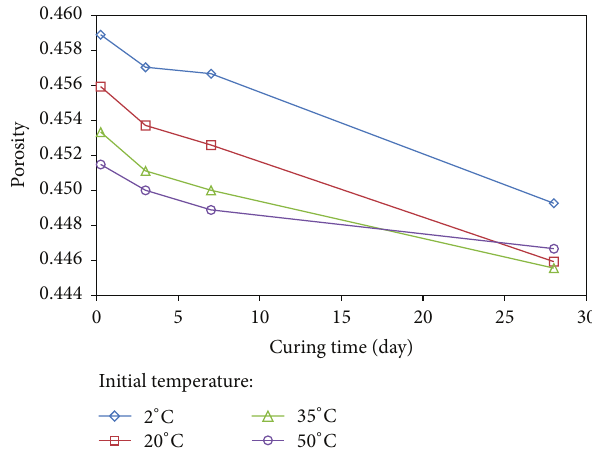
Figure 6: Effect of initial temperature on the evolution of porosity.